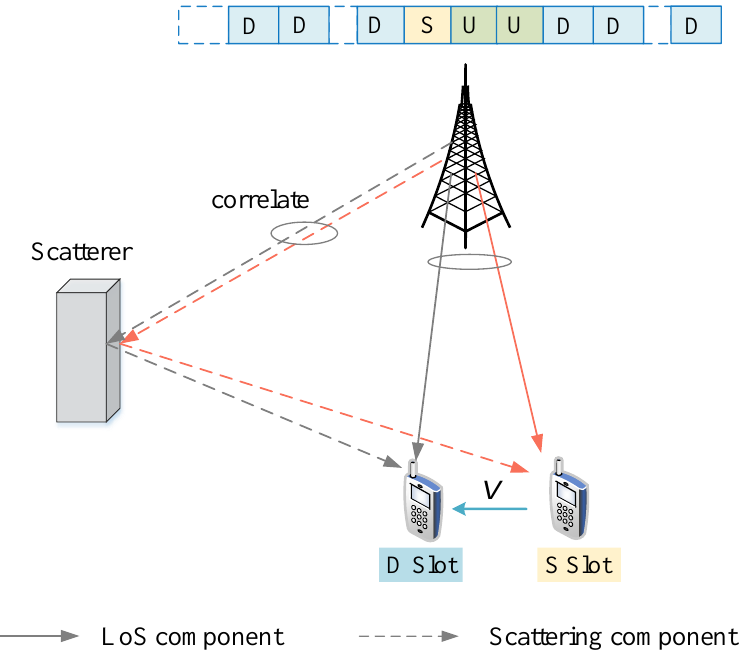
Figure 2. In TDD mobile communication systems, the interval between slots S and D is short in two adjacent SRS periods, and the LoS and scattering components are